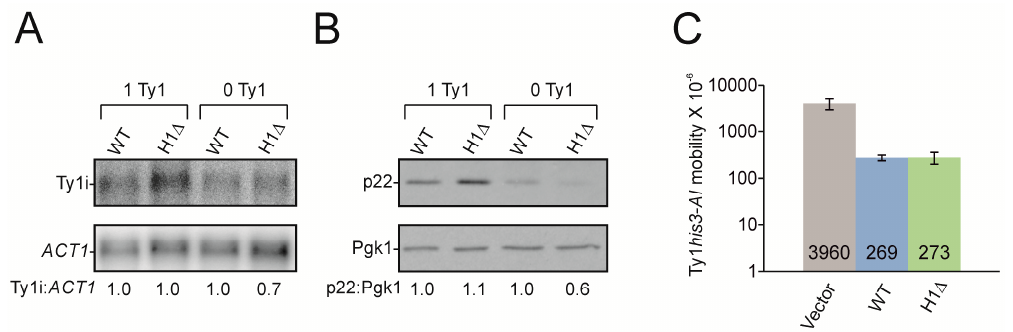
Figure 9. Effect of the hairpin H1 deletion on Ty1i RNA, p22 protein expression and Ty1 his3-AI mobility. ( A ) Northern blotting of total RNA from the 1 Ty1 strain (DG2196) and 0 Ty1 strain (DG3582) containing either wild type (WT) pGPOL ∆ or mutant pH1 ∆ plasmids. A [ 32 P]-labeled Ty1 riboprobe (nt 1266 to 1601) was used to detect Ty1i RNA. ACT1 mRNA served as a loading control. Below are Ty1i: ACT1 ratios as determined by phosphorimaging. ( B ) Whole cell extracts from strains used in (A) were immunoblotted with p18 antiserum to detect p22. Pgk1 served as a loading control. p22:Pgk1 ratios were determined by densitometry. ( C ) Quantitative Ty1 his3-AI mobility assayed in the 1 Ty1 strain containing one genomic Ty1 his3-AI element and empty vector, WT, or H1 ∆ plasmids. All strains were grown in glucose containing medium to repress GAL1 -promoted Ty1 expression. Bars denote standard deviation.